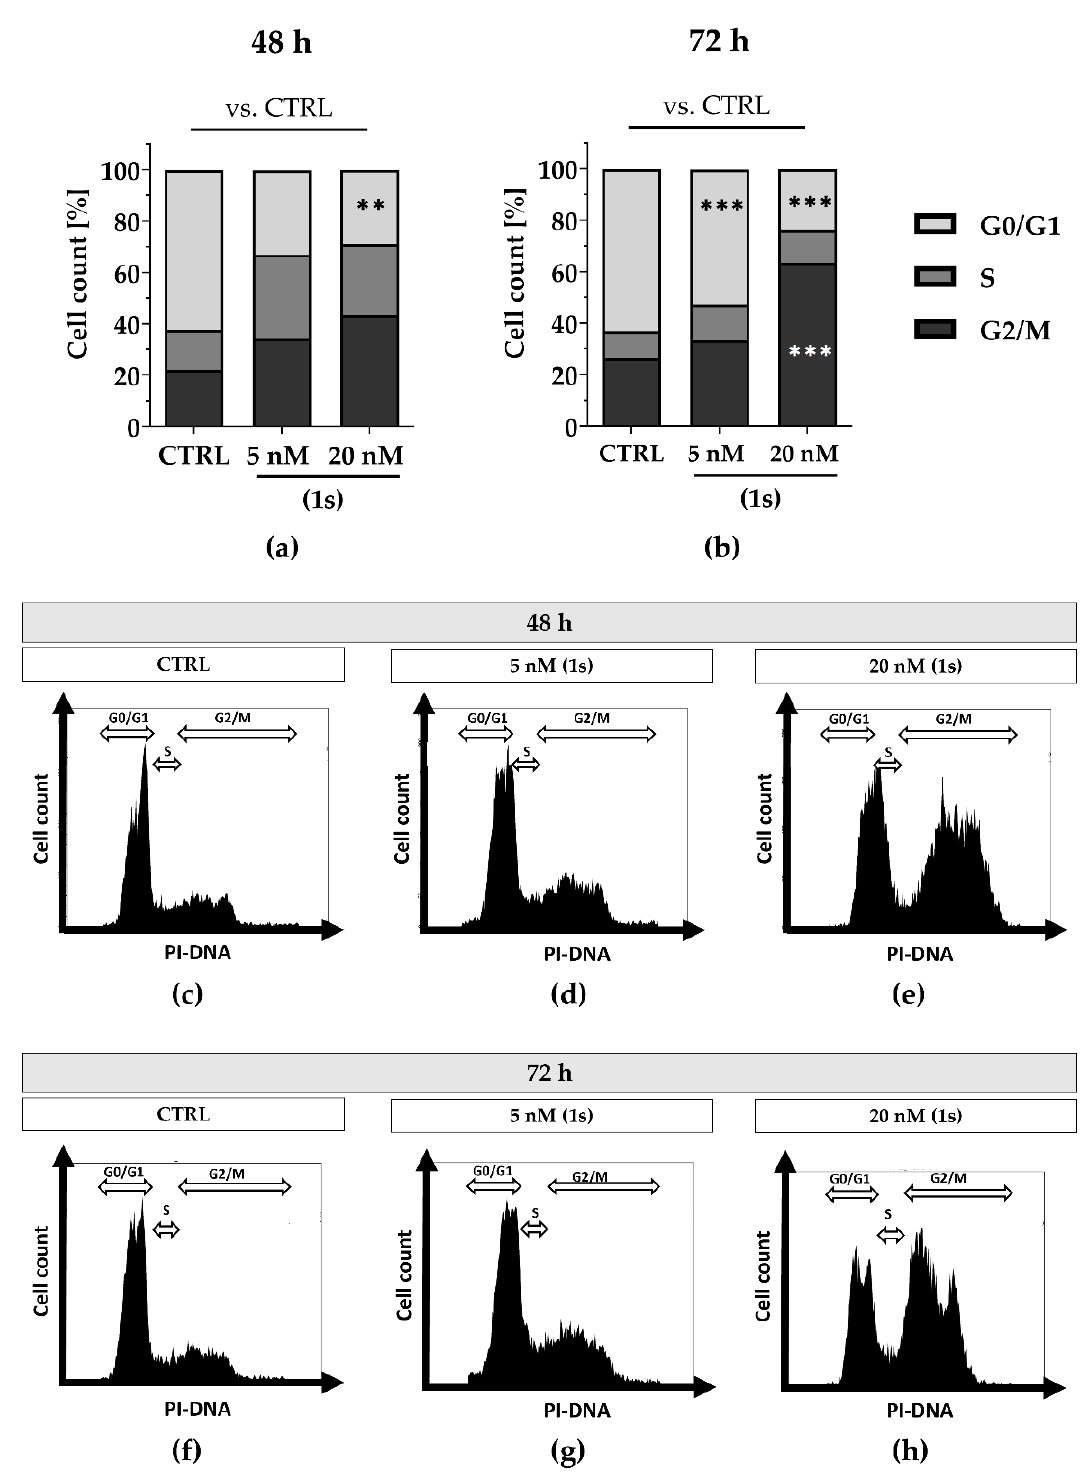
Figure 9. Compound ( 1s ) delays cell cycle progression in a time- and dose-dependent manner. Cells were grown for ( a , c – e ) 48 h or ( b , f – h ) 72 h without (CTRL) or in the presence of ( 1s ). Cell cycle phase population (G0/1; S; G2/M) was determined based on the signal of the PI-DNA complex using CytExpert. ( a , b ) Columns represent the mean ( n = 3). Statistical difference was calculated using two-way ANOVA vs. CTRL (** p < 0.01, *** p < 0.001). ( b – h ) Representative histograms depicting the cell count within the PI-signal were illustrated with CytExpert.